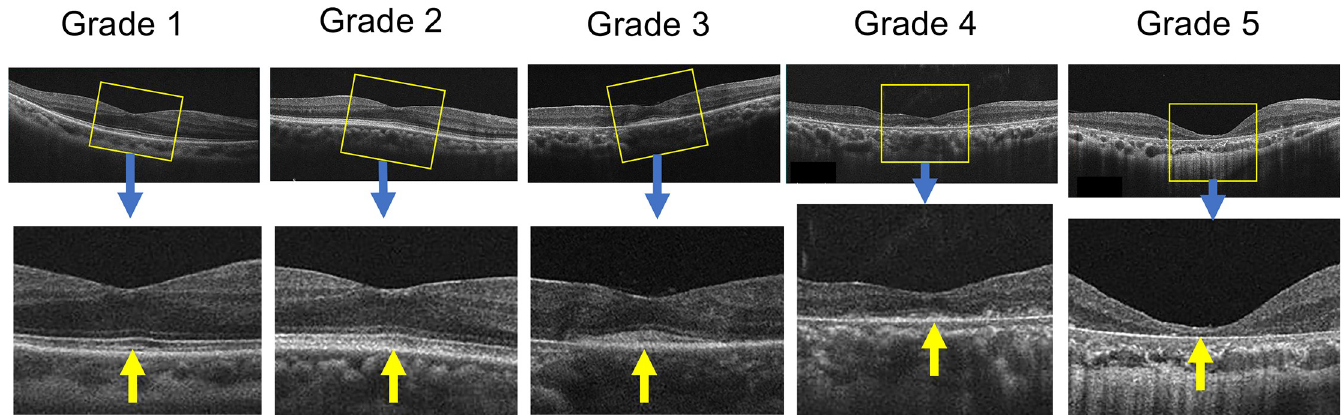
Fig 2. Sample SD-OCT pictures indicating each severity grade. Definition of grades: grade 1, almost a normal foveal structure or sharply defined IS-EZ and IZ at the foveal center (yellow arrow); grade 2, partial hyperreflective changes in the IS/OS layer of the foveal region or a broadened IZ (yellow arrow) and/or IS-EZ without merging; grade 3, diffuse hyperreflective changes in the IS/OS layer or broad IS-EZ changes in the foveal region or merging of the broadened IS-EZ and IZ (yellow arrow); grade 4, remnants of the IS/OS-like structure on the retinal pigment epithelium (yellow arrow); grade 5, absent IS/OS-like structure (yellow arrow).